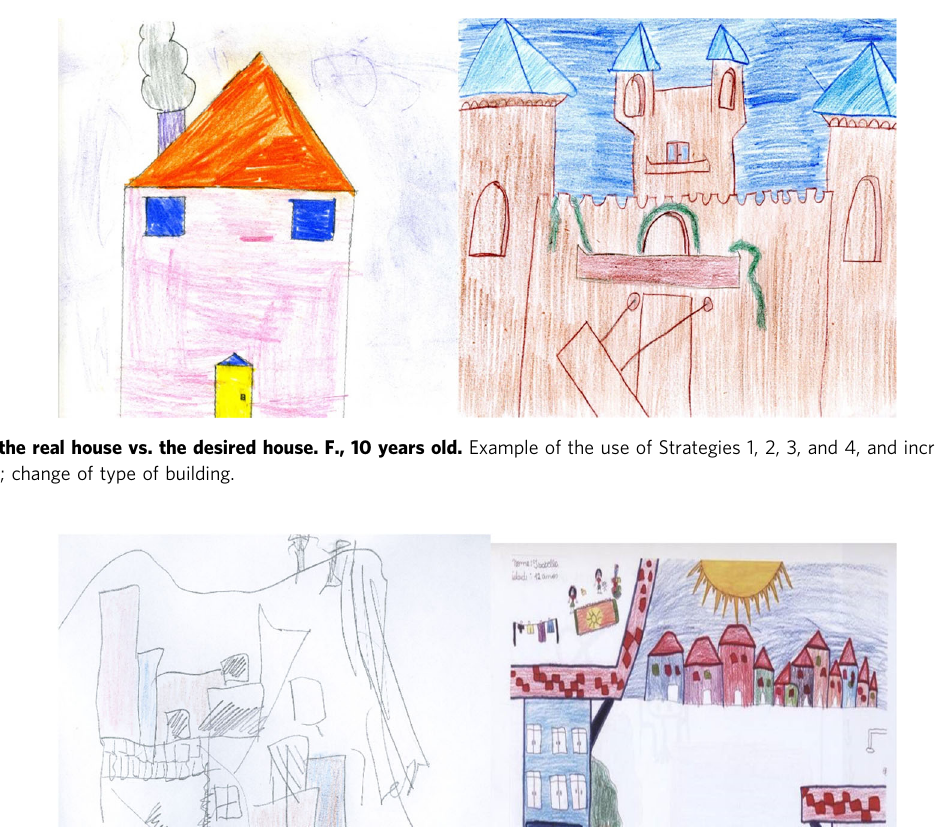
Fig. 1 Drawing of the real house vs. the desired house. F., 8 years old. Example of use of Strategies 1, 2, and 3, and increases in architectural details, colors, and dimensions.